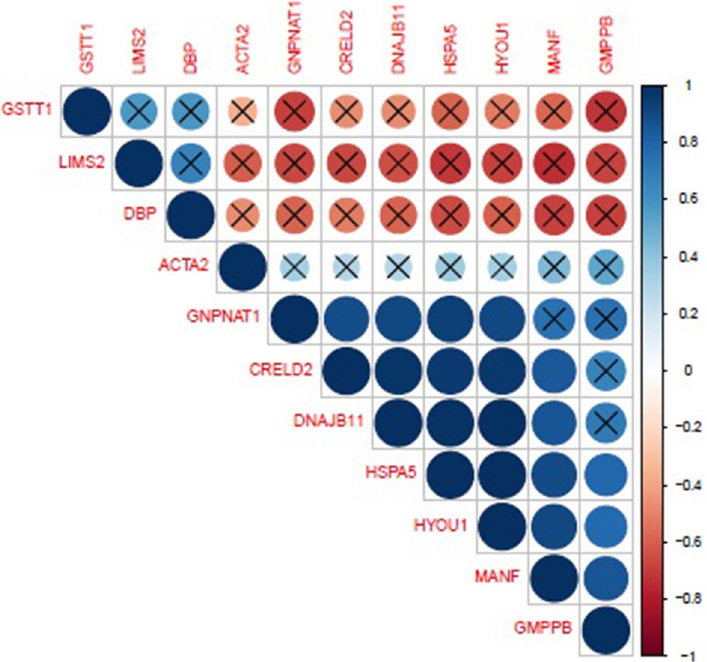
Figure 2. Correlogram highlighting the correlation between DEGs in skeletal muscle tissue from high and low RFI bulls. Visual representation of the correlation matrix highlighting the most correlated DEGs in hepatic tissue from high and low RFI bulls. Blue circles (correlation value 1) indicate a high correlation between DEGs while red circles (correlation value − 1) indicate no correlation between DEGs. Non-significant correlations are denoted as X. This image was generated through the use of the R (v3.4) Corrplot package 65 .